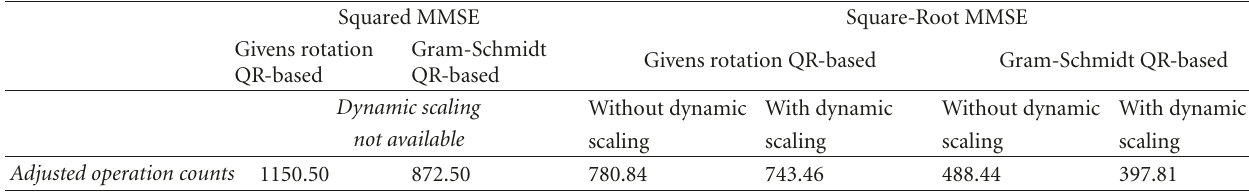
(cid:2) n (4 × 4 MMSE detection).